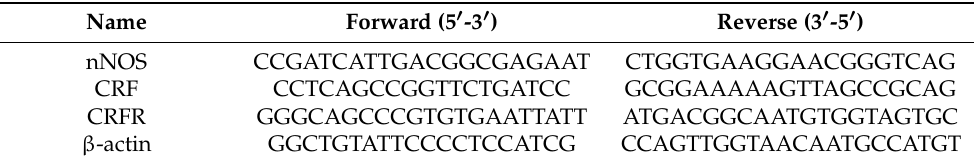
Table 1. Primers used in quantitative real-time polymerase chain reaction (RT-PCR)